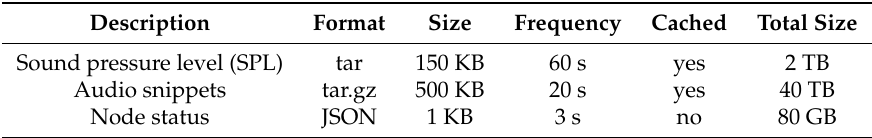
Table 2. Collected data type summary ordered by descending priority including total collected size to